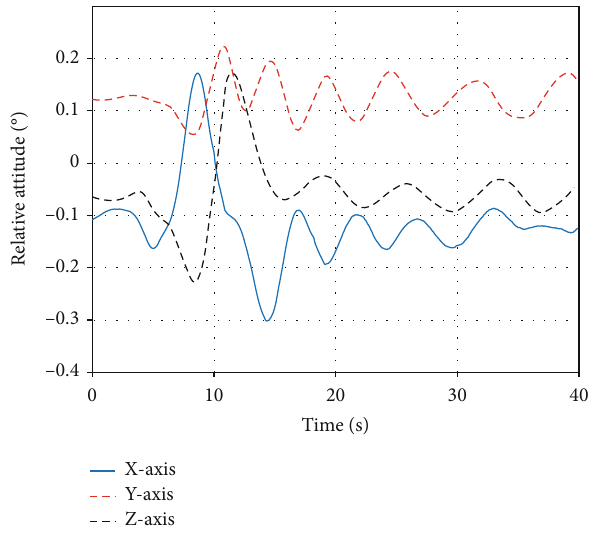
Figure 11: Relative attitude between two modules with compound controller.